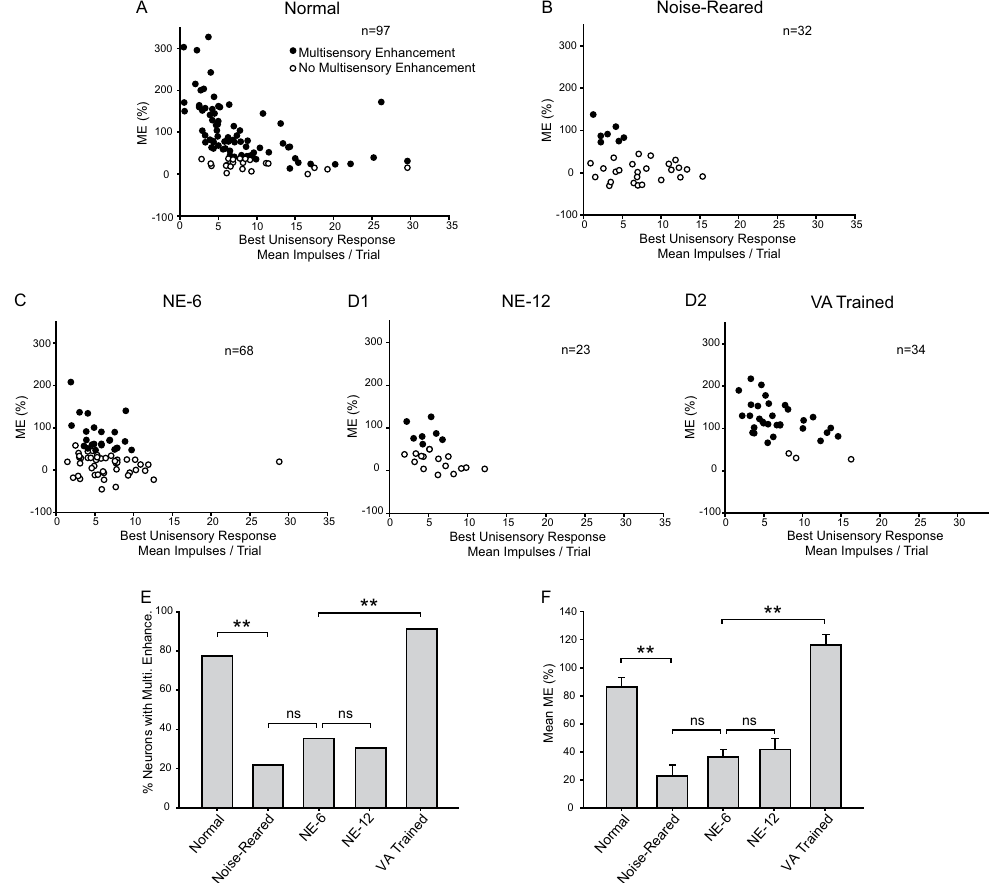
Figure 5. Population comparison of the relative effectiveness of normal housing versus cross-modal exposure in instantiating multisensory integration capabilities. ( A ) A high proportion of neurons exhibit multisensory enhancement capabilities in normal animals. ( B ) However, few SC neurons in noise-reared animals exhibited this capacity. ( C ) This proportion increased somewhat, but not significantly, when those animals were subsequently housed in a normal environment for 6 months (NE-6). ( D1 ) This proportion also failed to change significantly in animals remaining in that housing condition for an additional 6 months (NE-12). ( D2 ) However, the animals given once weekly cross-modal exposure sessions over an equivalent period did achieve a normal incidence of neurons with this capacity (VA trained). E and F ) Group differences were evident in the summary bar graphs which compare the incidences of multisensory enhancement ( E ), and the mean ME magnitudes ( F ) collapsed over the last 1.5 months of testing. n = number of